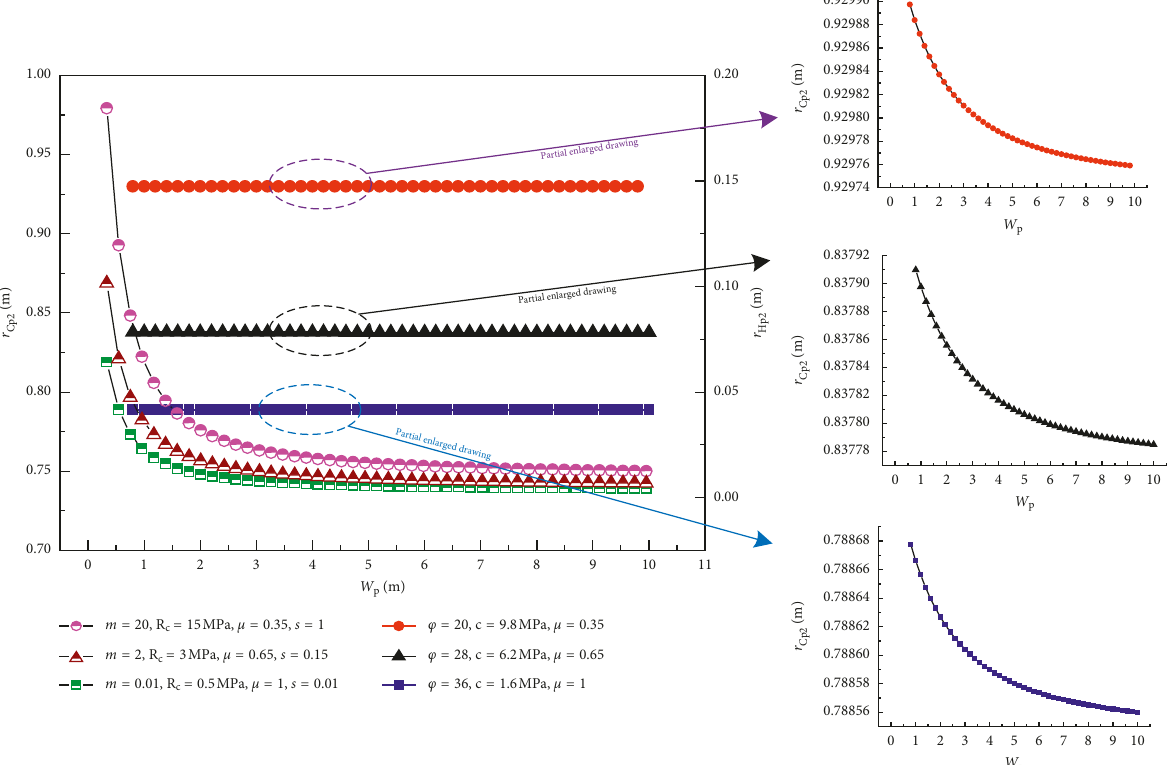
Figure 5: The influence curve of damaged width of rib pillar by width of retaining rib pillar.